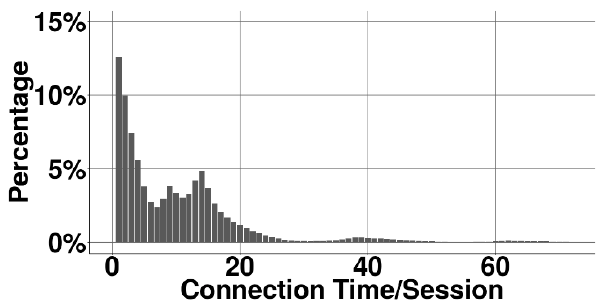
Figure 7. Distribution of connection times at level 2 charging stations binned per hour.